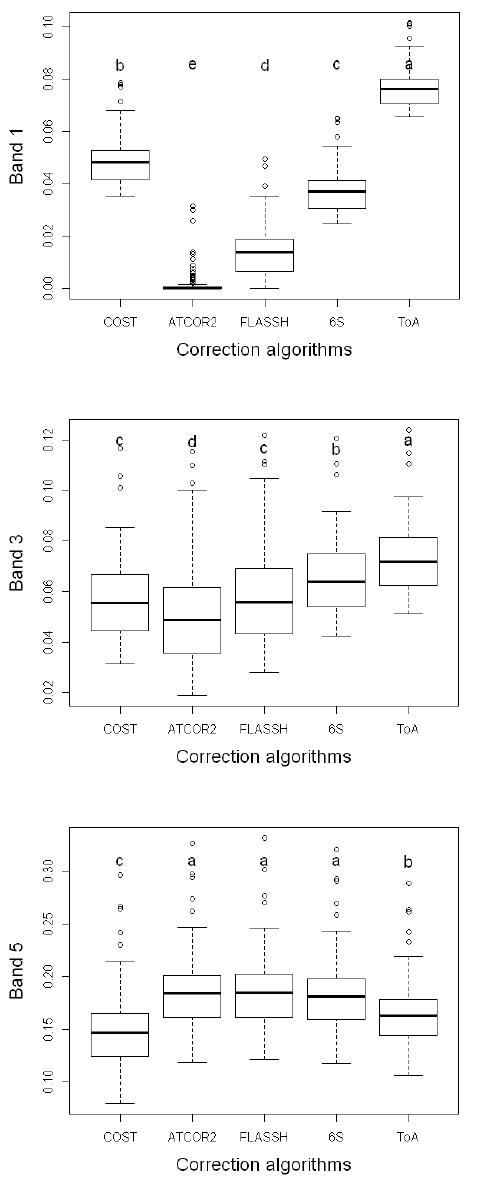
Figure 5. Box plots for each band of the Landsat 5 TM sensor and corresponding groupings of the radiometric correction algorithms (different letters indicate significant differences between algorithm performances, at p < 0.05).